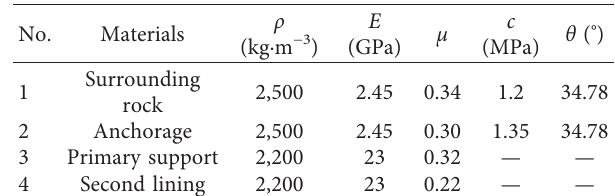
Figure 1: Structure schematic of underground transfer-station intersection: (a) arch-arch; (b) arch-wall. Table 1: Parameters of the material.